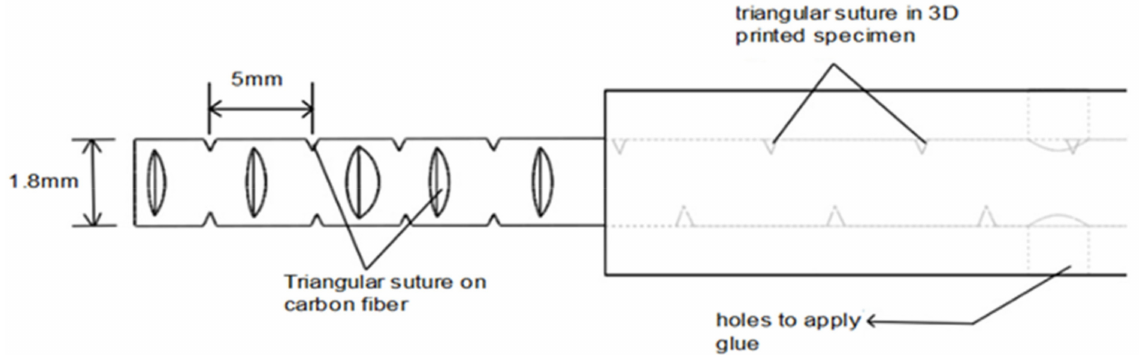
Figure 1. Solid carbon fiber (CF) rod and 3D printed specimen with triangular interlock